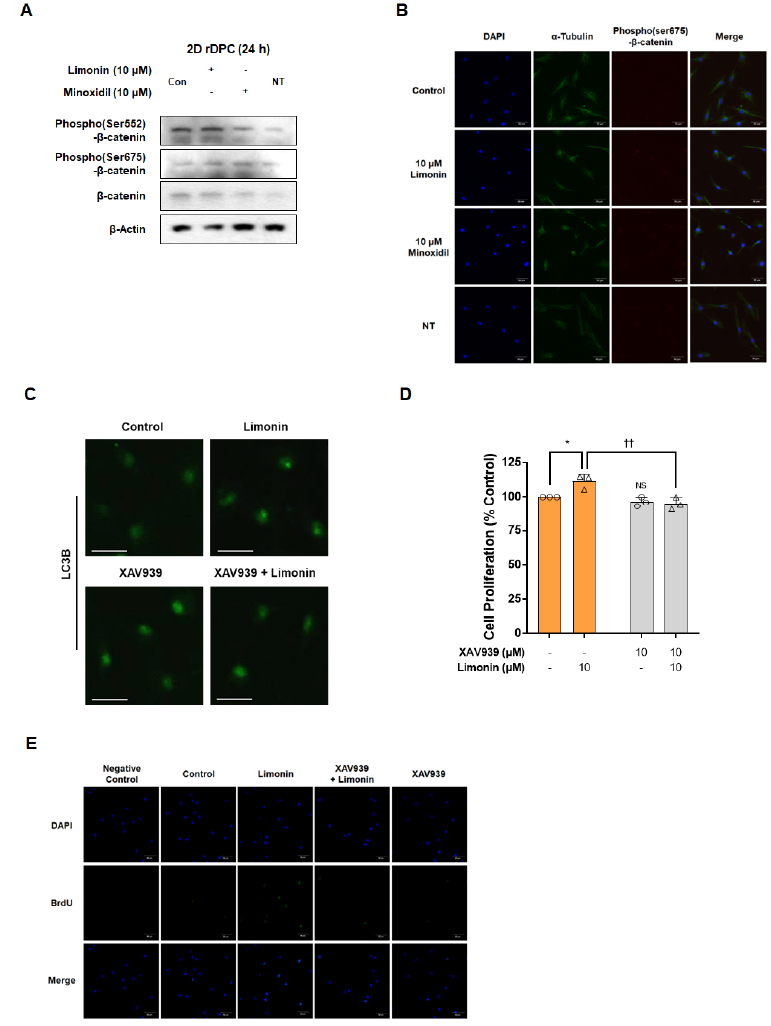
Figure 3. Limonin induces cell proliferation via activation of the Wnt/ β -catenin pathway in two- dimensional (2D) cultured rDPC. ( A ) Representative images of Western blot for Wnt/ β -catenin- related proteins phospho(Ser552)- β -catenin and phospho(Ser675)- β -catenin after treatment with limonin and minoxidil for 24 h. ( B ) Confocal microscopy images for changes in the cellular localization of phospho(Ser675)- β -catenin after treatment with limonin and minoxidil for 1 h. ( C ) Confocal microscopy images of changes in the number of LC3B puncta after treatment with limonin for 24 h in the absence or presence of XAV939. ( D ) Changes in the proliferation of 2D rDPC after treatment with limonin for 3 days with or without XAV939. ( E ) Confocal microscopy images for changes in the number of BrdU-positive cells after treatment with limonin for 24 h in the absence or presence of XAV939. * p < 0.05 vs. vehicle-treated control. †† p < 0.01 vs. limonin alone. Scale bars, 50 μ m. Con, vehicle-treated control; NT, not treated; NS, not significant.